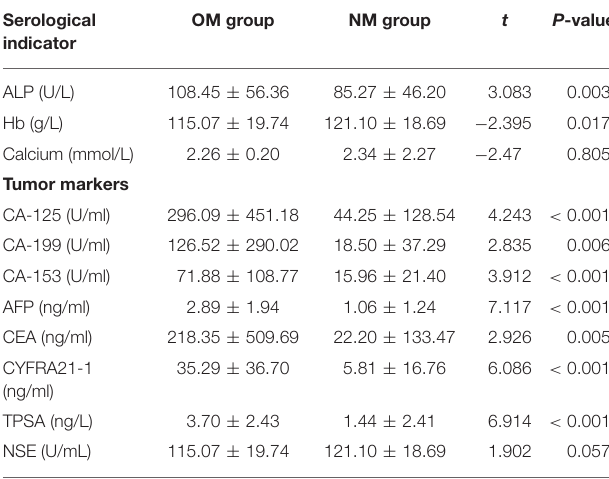
TABLE 1 | Clinical characteristics of patients with ocular metastasis of lung cancer.